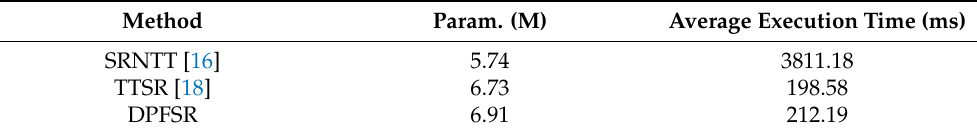
Table 6. Comparison of the number of network parameters and execution time. The methods used for comparison are all patch-based RefSR methods.